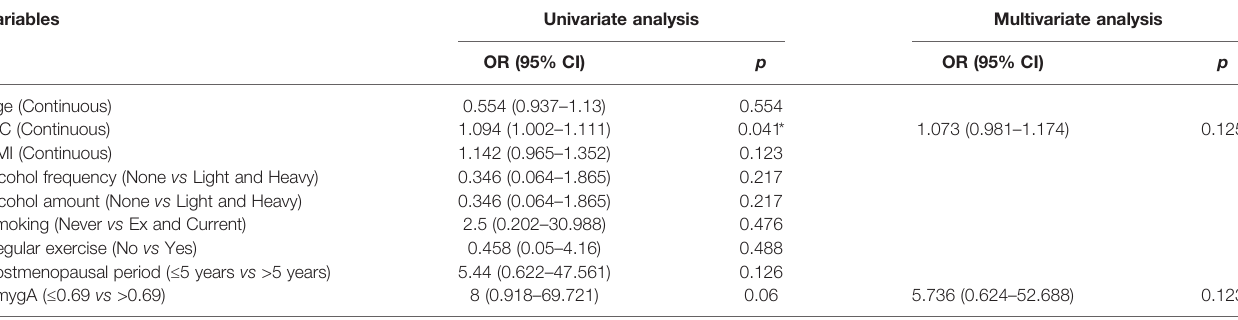
TABLE 5 | Uni- and multivariate logistic regression analyses for the associated predictors of osteoporosis in postmenopausal women with moderate risk of stress. Variables Univariate analysis Multivariate analysis